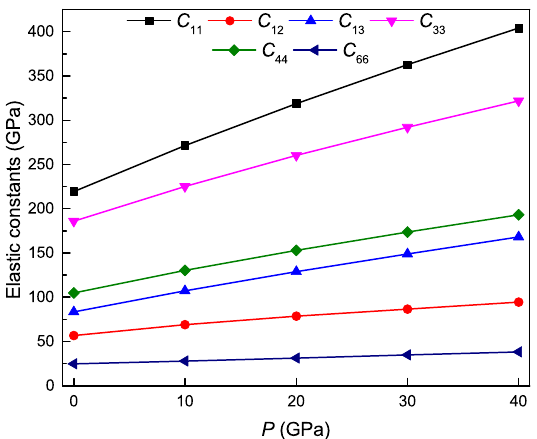
Figure 3. Elastic constants as a function of pressure for the Ti 4 Nb 3 Al 9 phase.